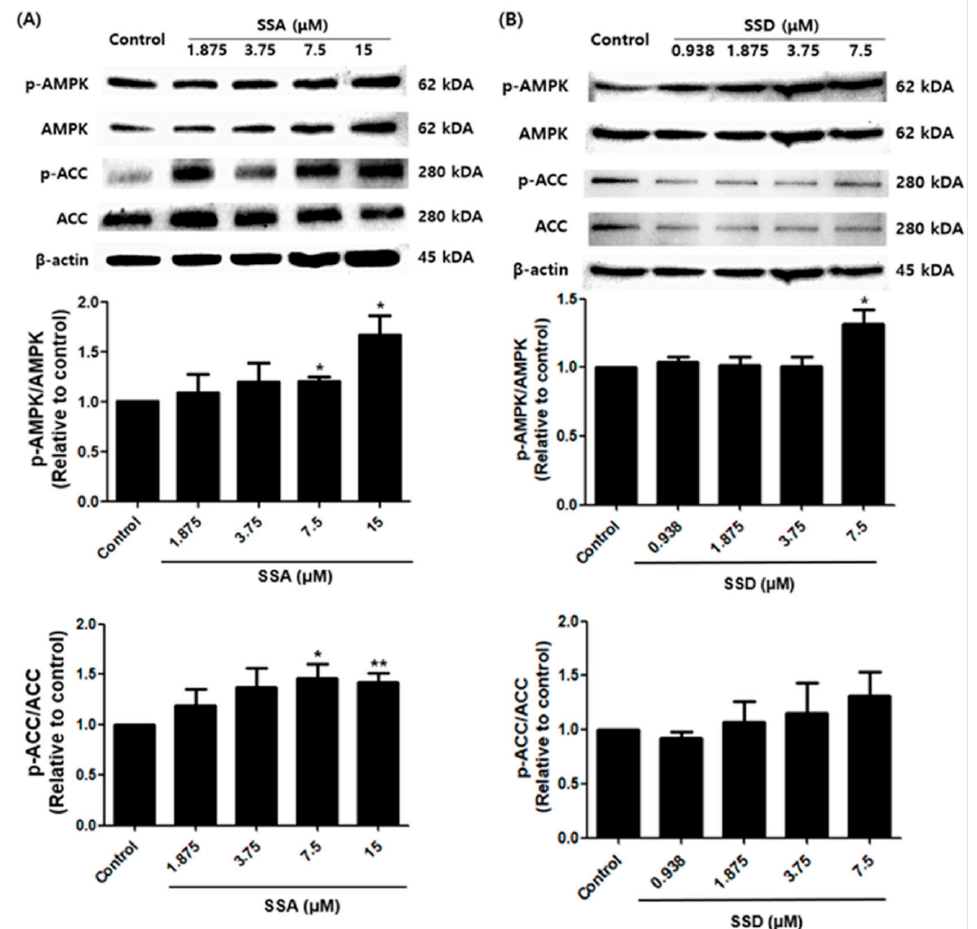
Figure 6. Effect of SSA ( A ) and SSD ( B ) on adipogenesis is mediated by AMPK signaling pathway as examined by Western blot analysis. The graphs show the band intensity ratio of the phosphorylated form by the total protein expression of AMPK and ACC. Results are shown as a relative of control (0.5% DMSO) values for this experiment. β -actin was used as a loading control. Data are mean ± standard error of the mean (SEM) of three independent experiments. * p < 0.05, ** p < 0.01, compared with control, *: increased compared to